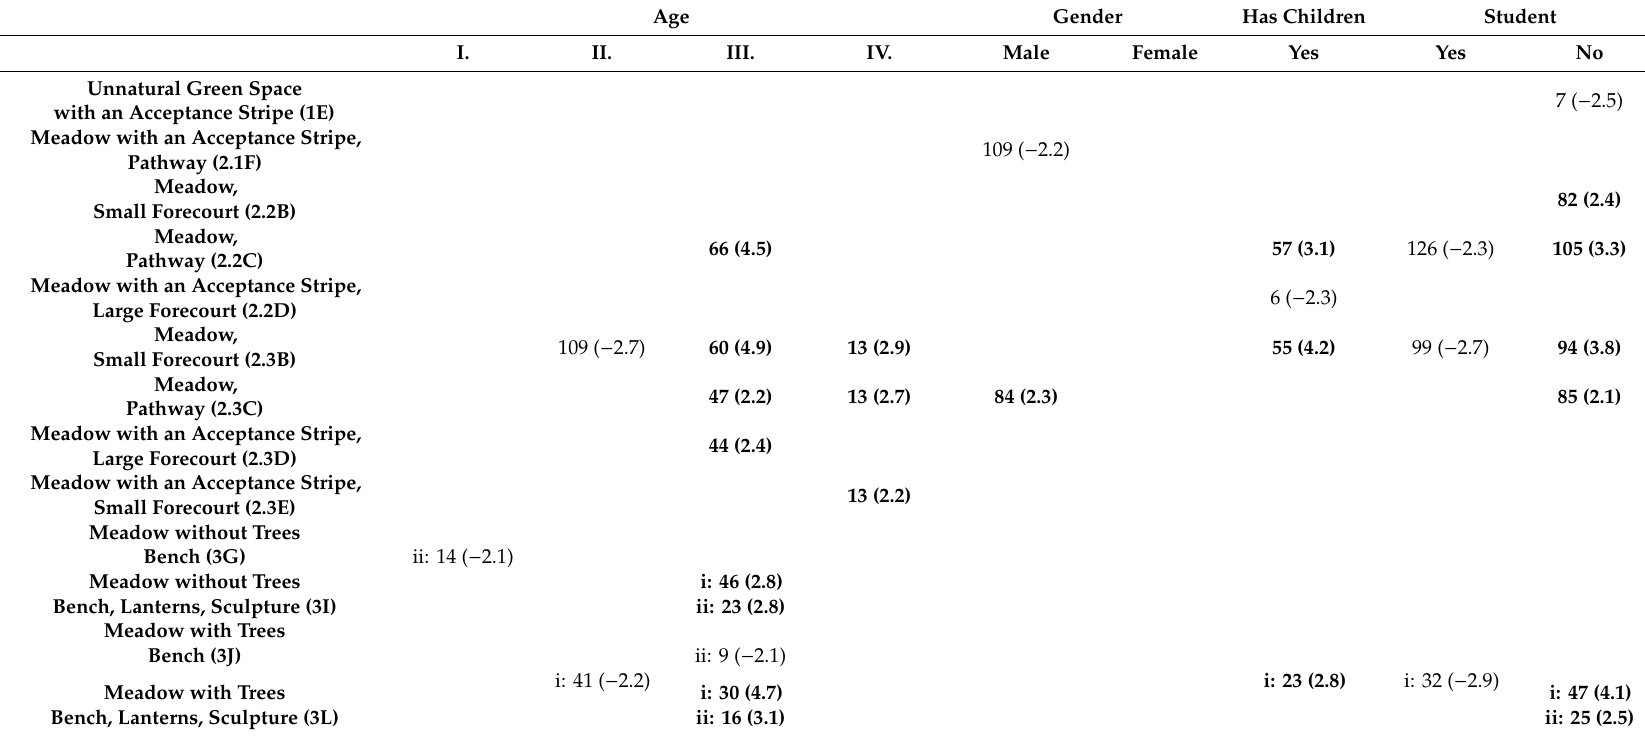
Table A2. Table of all the presented meadow areas that were significant with respect to age, gender, people with children, students, and non-students. The table presents the number of choices for a certain green space by the respective sociodemographic group (standardized residuals in brackets). Whereas a positive residual indicates that the scenario was appreciated by the relevant demographic group (bold type), a negative residual indicates that the scenario was disliked (normal typeface). Question 3 was divided into four sub-questions; each picture was presented twice as two separate questions: the results of (i) the first sub-question are shown in the upper line; results of (ii) the second sub-question in the lower line. Age Has